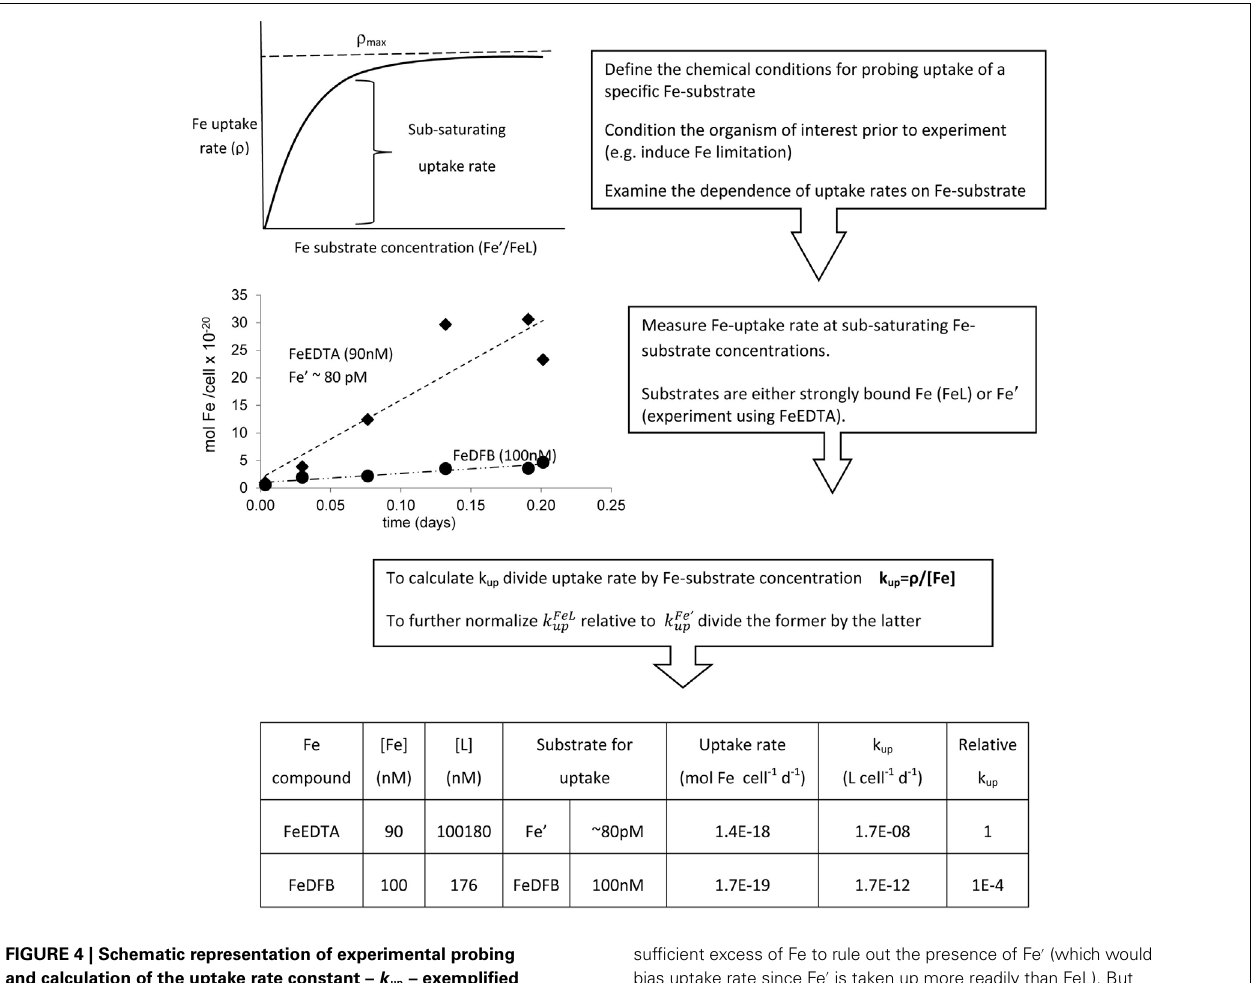
FIGURE 4 | Schematic representation of experimental probing and calculation of the uptake rate constant – k up – exemplified with Fe-limited Emiliania huxleyi uptake data. Note that the complexing ligand L for strong ligands such as DFB should be in